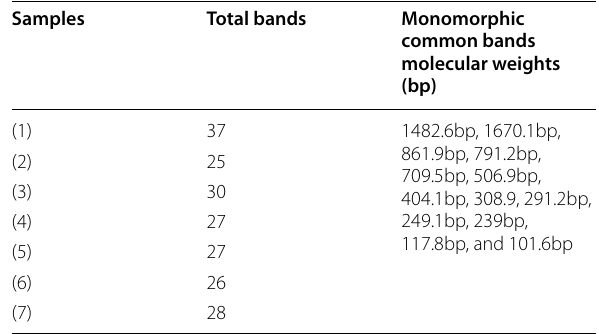
Table 6 List of specific markers for Dimocarpus longan for AFLP marker profile with number of total bands in treatments and their markers molecular weights (MW) in bp Samples